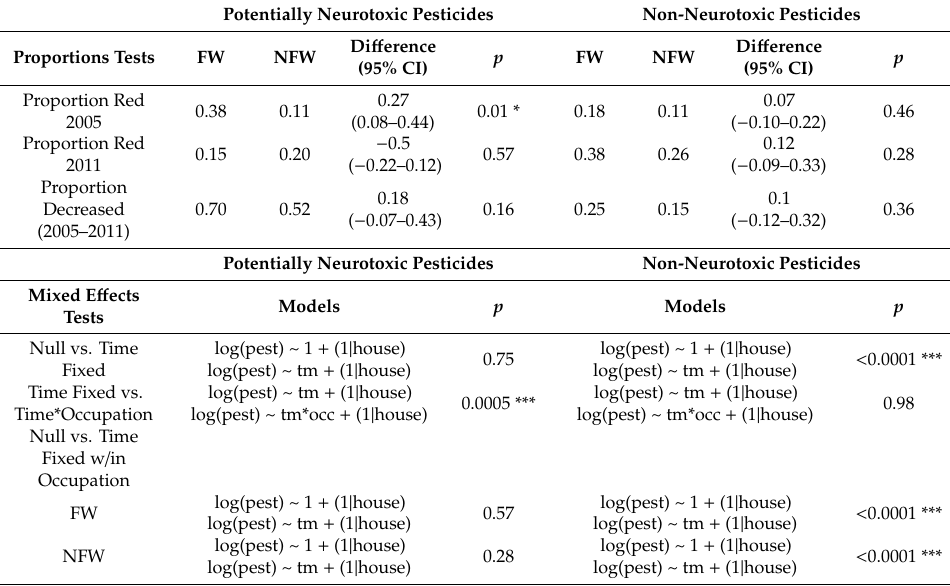
Table 2. Statistical summary table for unweighted neurodevelopmental exposome analysis. Proportion tests: for both neurotoxicity groupings, the proportion of “red” FW households in Figure 1 (levels greater than 17.6 µ mol / g) was compared with the proportion of red NFW households for both study years (2005 and 2011). Table 2 provides the proportion of red FW households, the proportion of red NFW households, the di ff erence between the two, and the associated p-value. Additionally, the proportion of FW vs. NFW households with decreased pesticide levels was compared for both study years. Mixed e ff ects tests: Table 2 also provides the mixed e ff ects models used to examine cohort-wide trends in potentially neurotoxic and non-neurotoxic pesticides over time, which models were compared in the analysis, and whether those models were significantly di ff erent from one another. * p < 0.05; *** p <